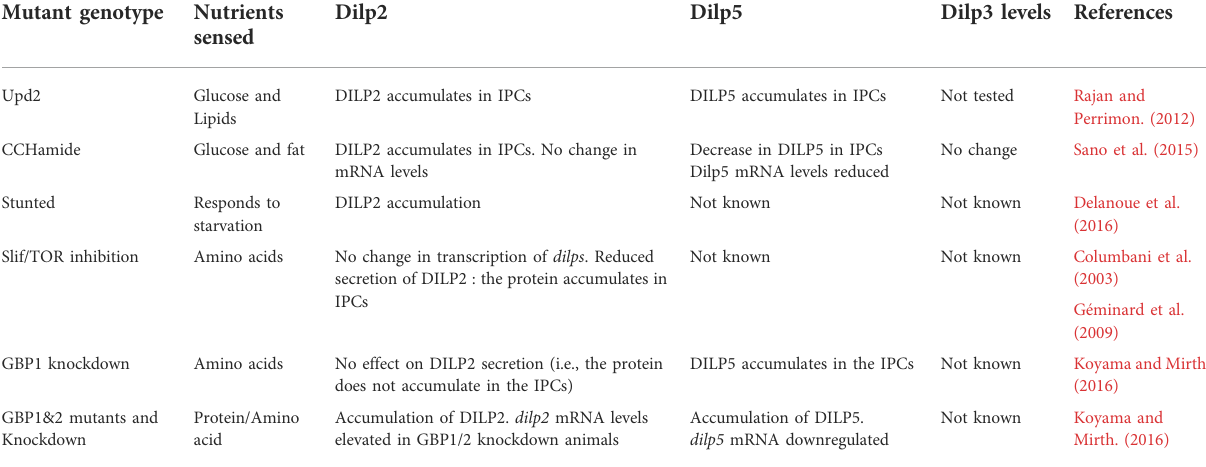
TABLE 1 Molecules associated with nutrient sensing and their effect on IPC derived